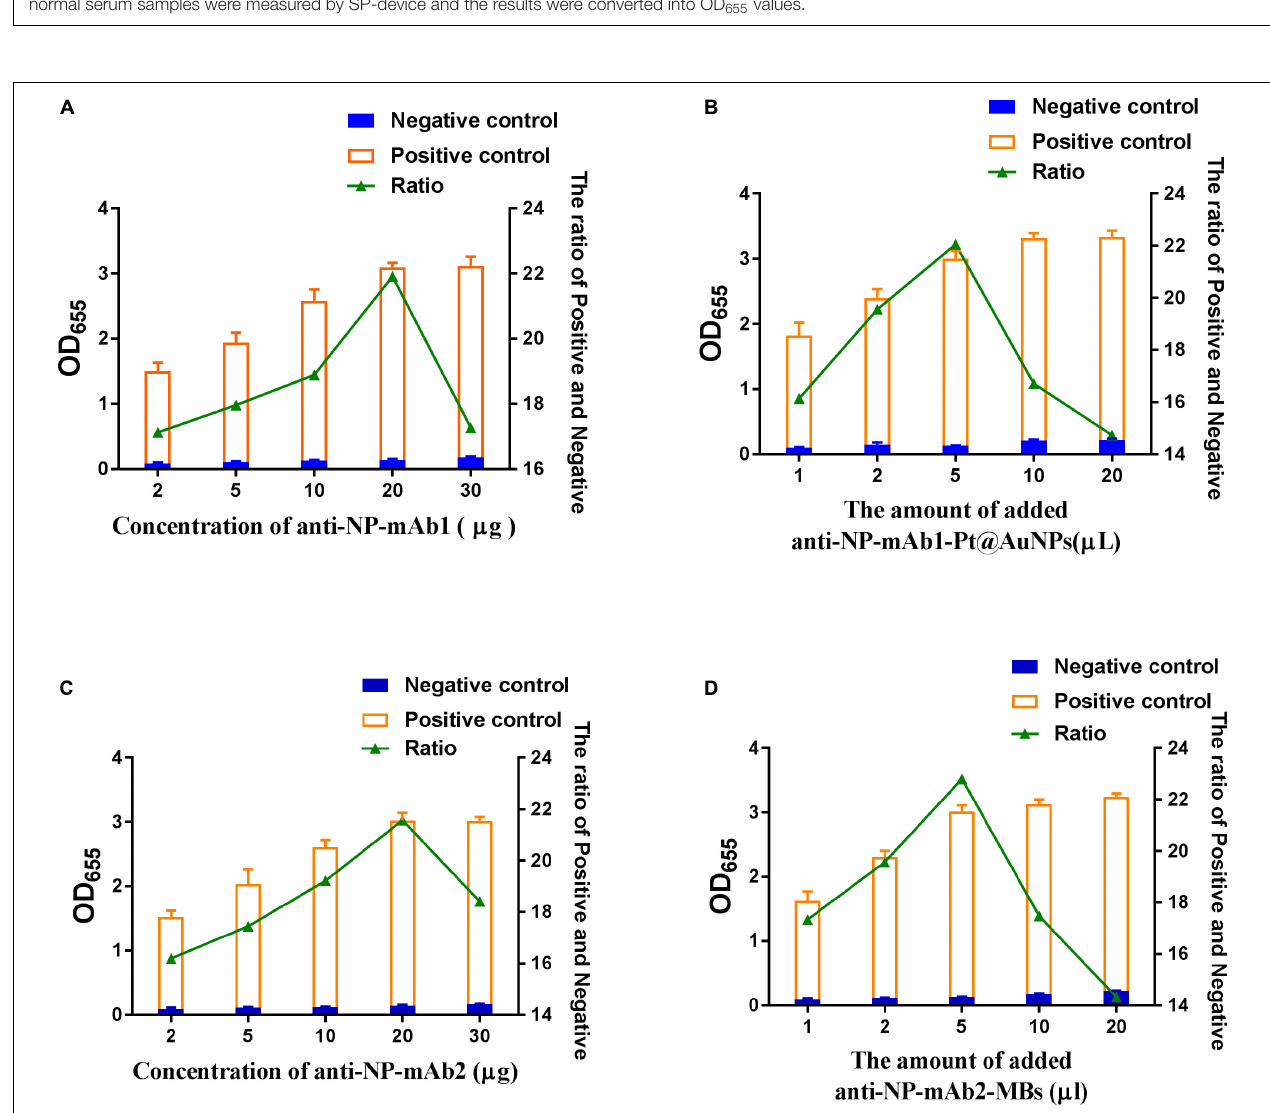
FIGURE 3 | The optimization of SP-NLISA. (A) The amounts of monoclonal antibodies (mAb1) labeled Pt@AuNPs were optimized. (B) The amounts of the mAb1-Pt@AuNPs were optimized. (C) The amounts of monoclonal antibodies (mAbs) labeled MBs were optimized. (D) The amounts of mAb2-MBs were optimized. A sample from a healthy blood donor was used as the negative control, and the addition of 1 µ g/mL NP standard in the negative control sample was used as the positive control.